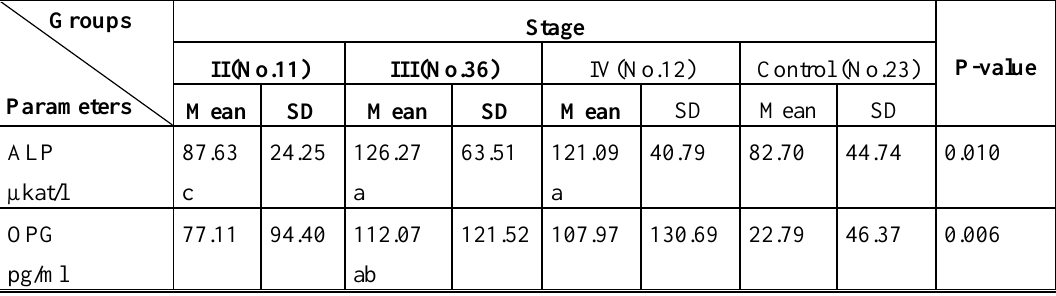
Table 2. Serum level of ALP and Osteoprotegerin through different stages of CKD patients compared to the control.